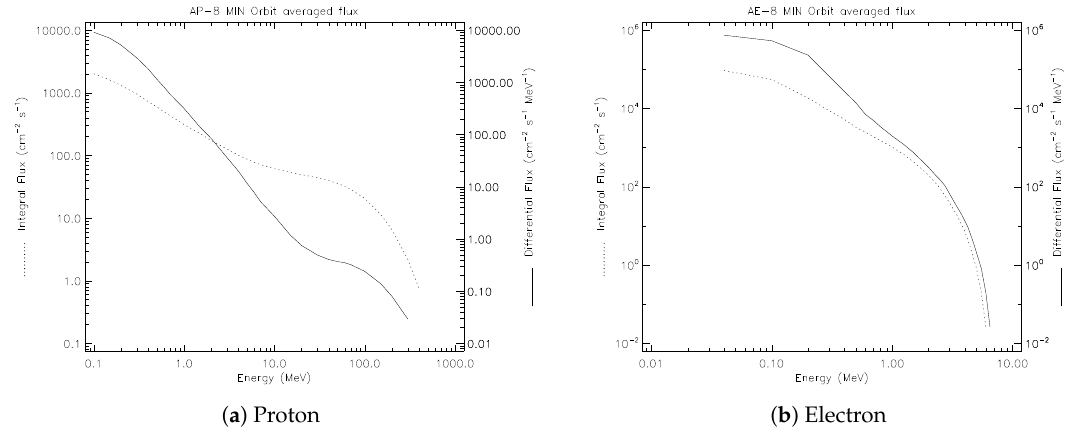
Figure 4. Flux of SAA-trapped protons and electrons during solar minimum, as obtained from